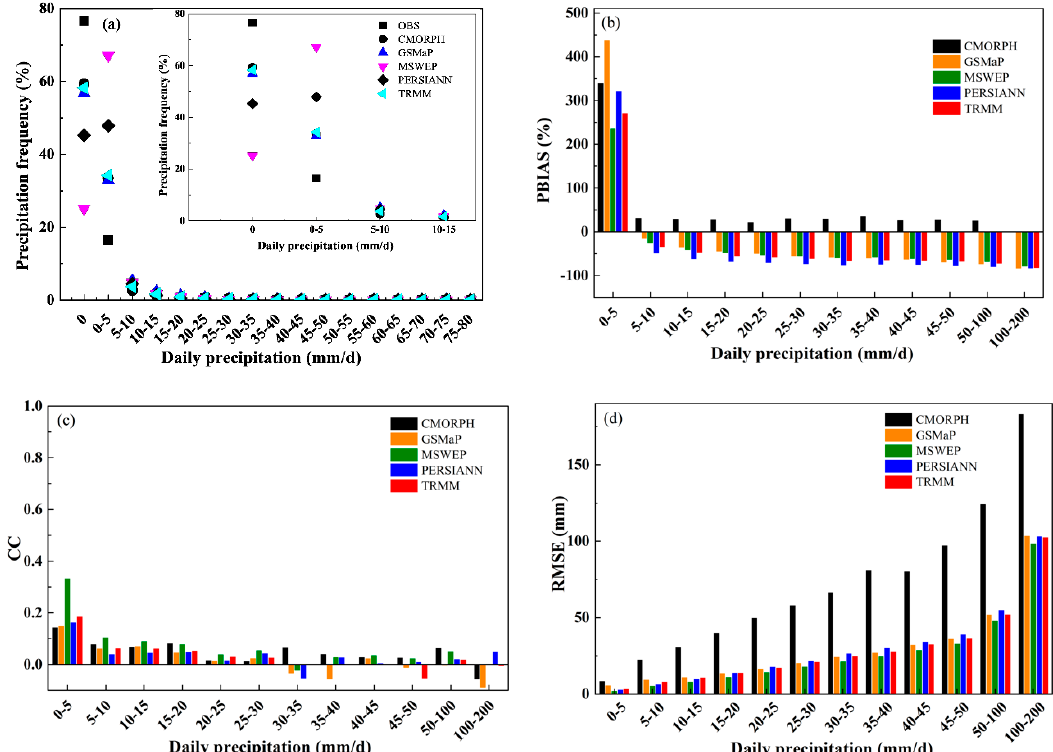
Figure 12. ( a ) precipitation frequency, ( b ) PBIAS, ( c ) correlation coefficient, ( d ) root mean square error for different precipitation level. PBIAS is bias, CC is correlation coefficient, RMSE is root mean square error.